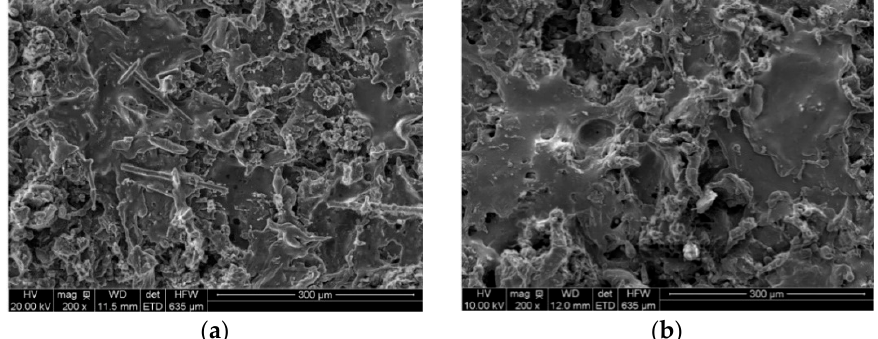
Figure 2. Surface views of arc sprayed aluminum-based coatings; ( a ) surface morphologies of the as-deposited Al-CF coatings deposited on the substrate; ( b ) surface morphologies of the as-deposited Al coatings deposited on the substrate.